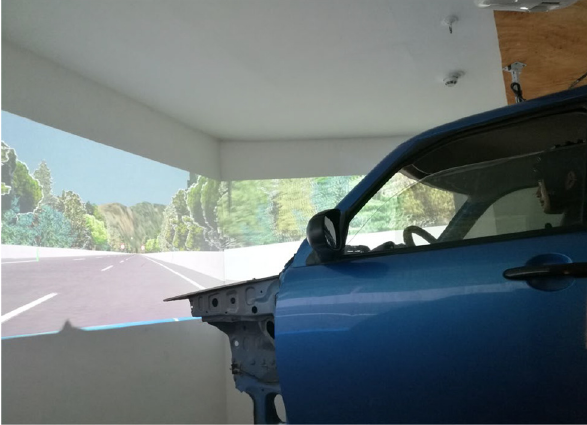
Figure 4 Distribution of signal acquisition channel of the NIRx